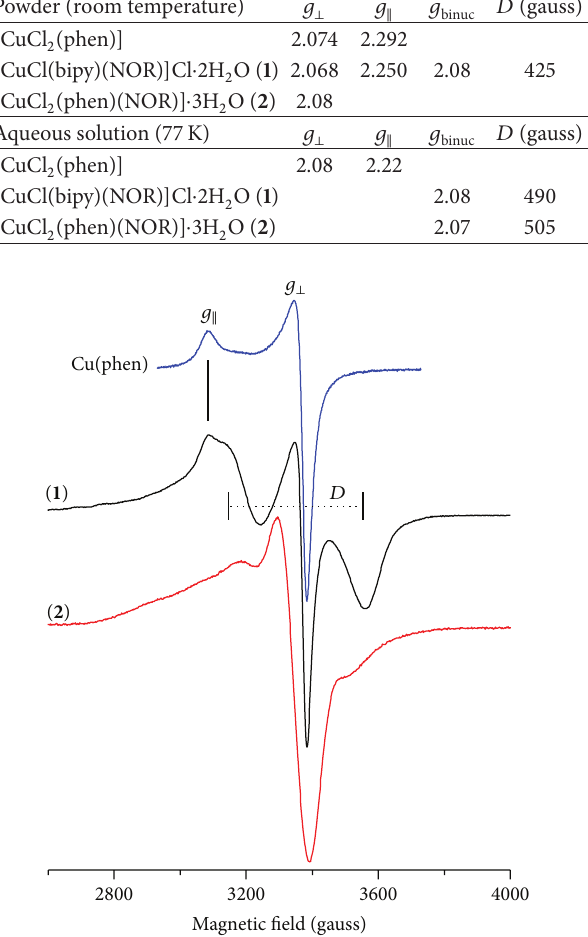
Figure 2: X-band EPR spectra of [CuCl 2 (phen)] and complexes 1 and 2 (powder, ambient